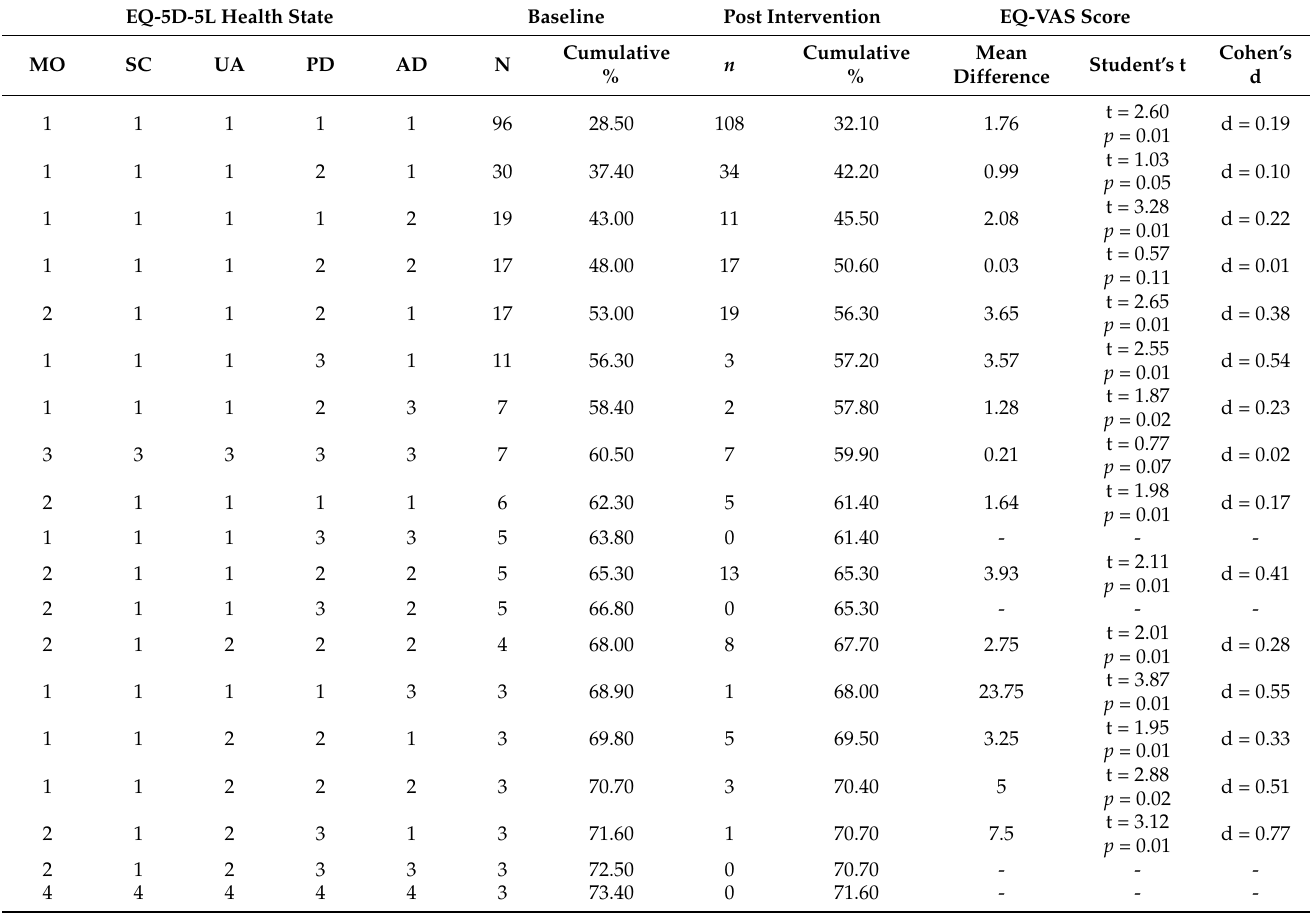
Table 3. EQ-5D-5L health